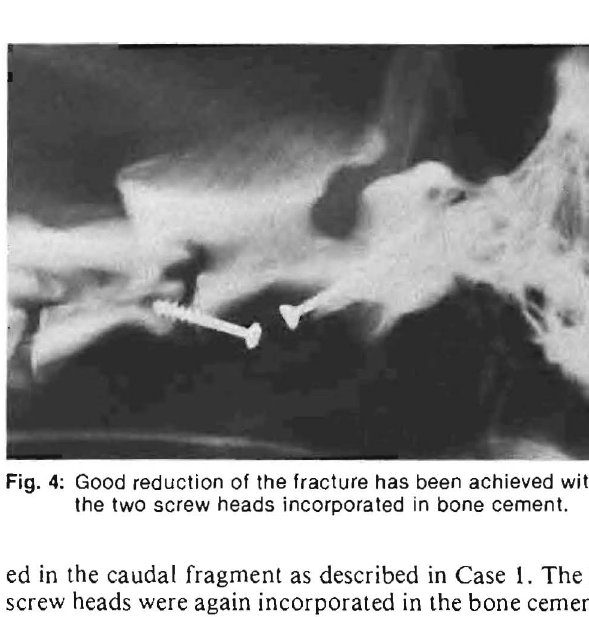
Fig. 4: Good reduction of the fracture has been achieved with the two screw heads incorporated in bone cement. ed in the caudal fragment as described in Case 1. The 2 screw heads were again incorporated in the bone cement to maintain reduction (Fig. 4).